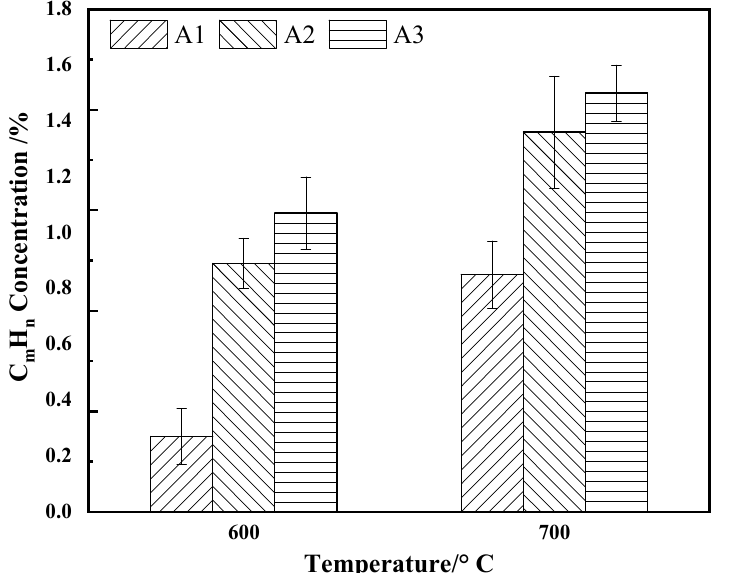
Figure 5. The concentration of small organic gas pollutants (C m H n ) during thermal desorption of simulated polluted soils under pure N 2 atmosphere at 600 ◦ C and 700 ◦ C. (A1, sample of 1 mL waste oil mixed with 25 g soil; A2, sample of 2 mL waste oil mixed with 25 g soil; A3, sample of 3 mL waste oil mixed with 25 g soil).